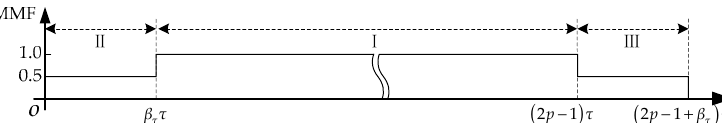
Figure 3. Longitudinal distribution of MMF.